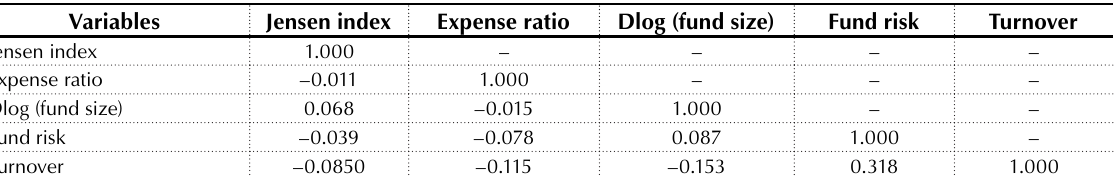
Table 6. Group B correlations